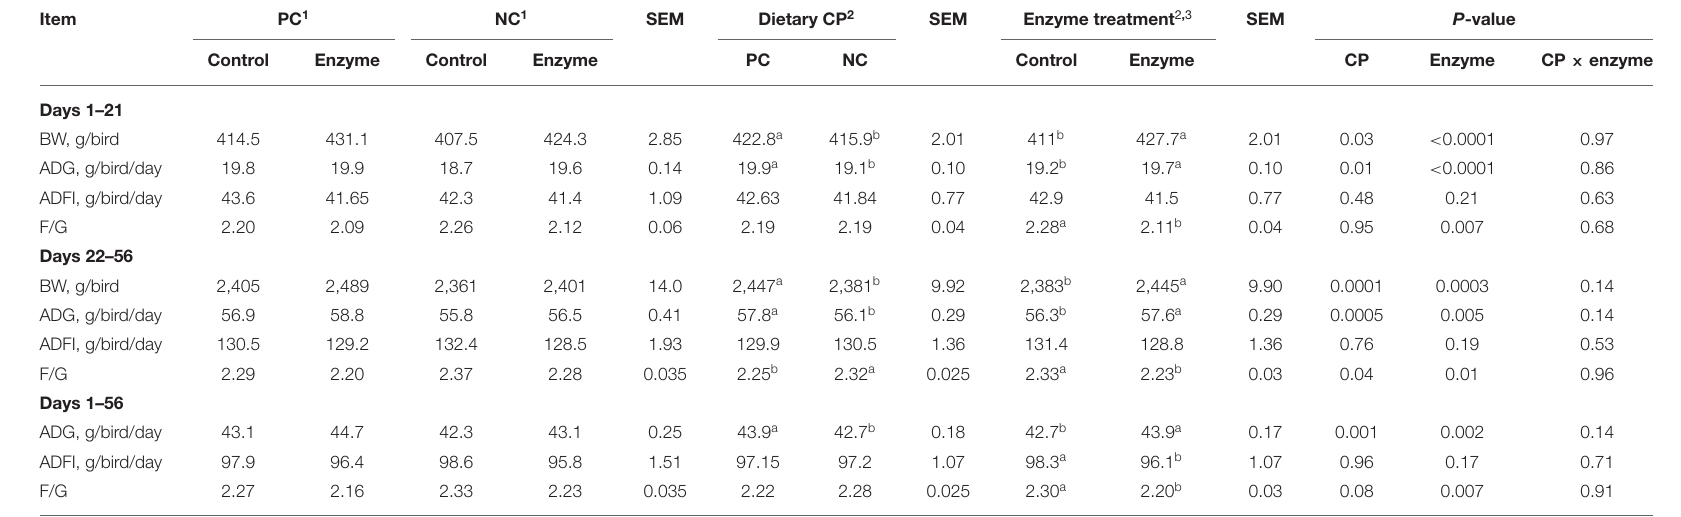
TABLE 2 | Effects of NSP enzymes and protease on growth performance of yellow-feathered broilers fed with diets with different CP levels during days 1–56.